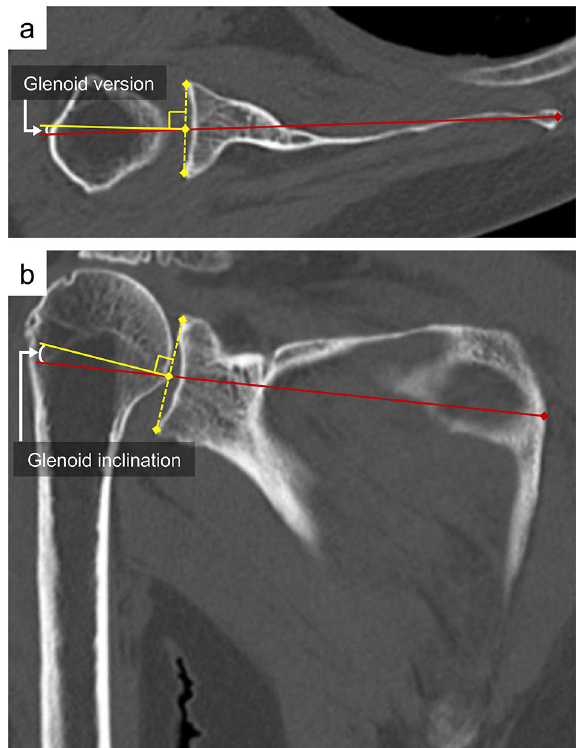
Figure 3. Pre-operative measurement of glenoid version and inclination. ( a ) Glenoid version was defined as the angle between Friedman’s axis and a line perpendicular to the line between the anterior and posterior rims of the glenoid. ( b ) Glenoid inclination was defined as the angle between Friedman’s axis and a line perpendicular to the line between the superior and inferior rims of the glenoid.